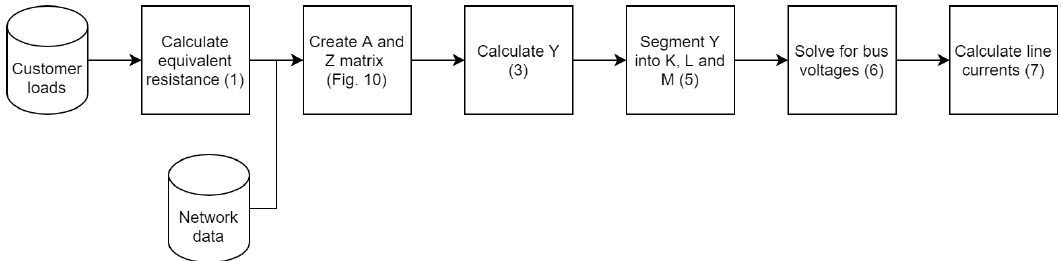
Figure 14. Diagram of the steps for solving the linear load flow